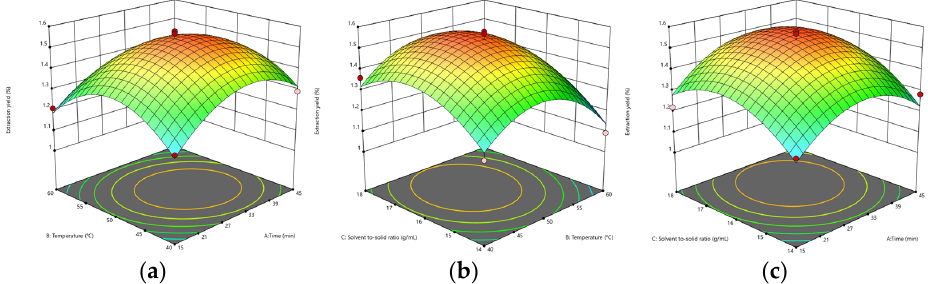
Figure 5. The effect of time and temperature on the yield of UA extraction ( a ), the effect of solid–liquid ratio and temperature on the yield of UA extraction ( b ), and the effect of solid–liquid ratio and time on the yield of UA extraction ( c ).